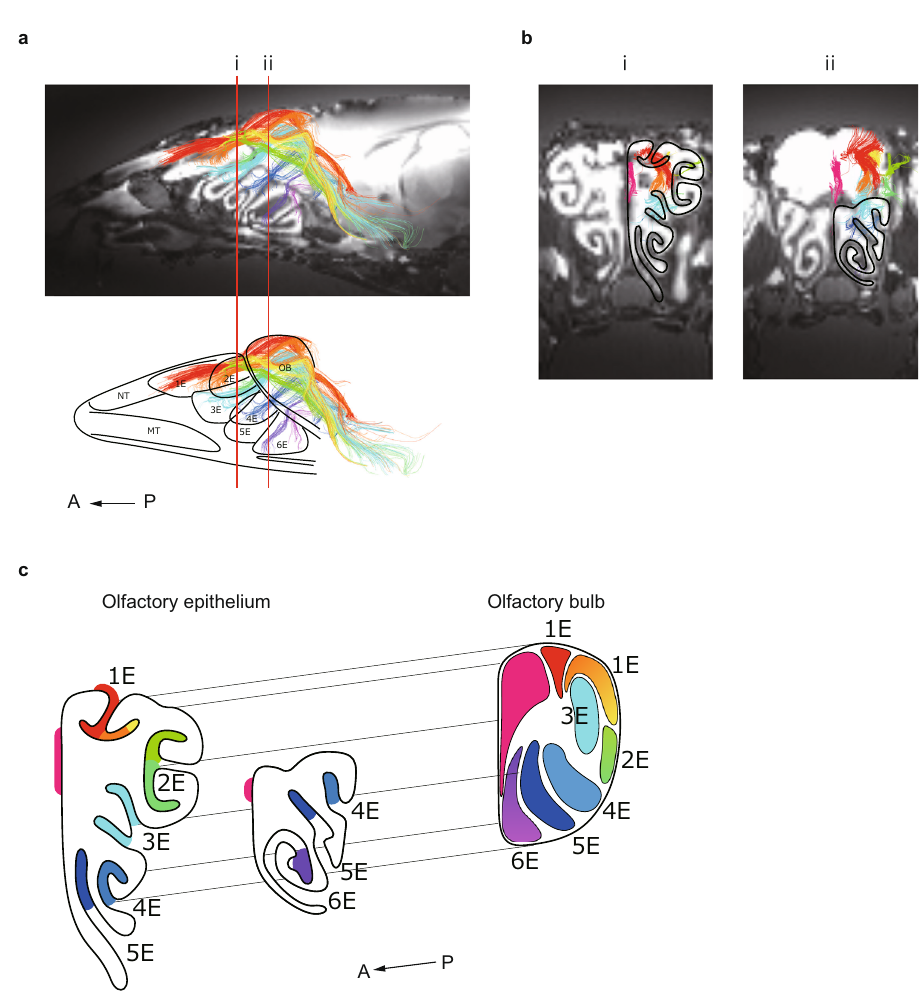
Fig. 2 The topographical relationships of the olfactory nerves running between the olfactory epithelium and olfactory bulb of the mouse. a Sagittal sections depicting the nerve pathways projecting from the olfactory epithelium to the olfactory bulb. The fi bers are color-coded according to their distribution in the olfactory epithelium (more than one region of interest was selected at some sites, such as the fi rst, second and sixth ethmoturbinates). 1E – 6E, fi rst to sixth ethmoturbinate; A anterior, MT maxilloturbinate, NT nasoturbinate, OB olfactory bulb, P posterior. b Coronal sections of the same nerves depicted in Fig. 2a. i: rostral, ii: caudal. The nerve fi bers were aligned in the medial-lateral axis. c Schematic diagram showing the DTT-based olfactory nerve map for the mouse (the distribution of the olfactory nerves running between the olfactory epithelium and olfactory bulb). Topographically, there was a correlation between the distributions in the olfactory epithelium and olfactory bulb in both the dorsal-ventral and medial-lateral axes. 1E – 6E, fi rst to sixth ethmoturbinate; A anterior, P